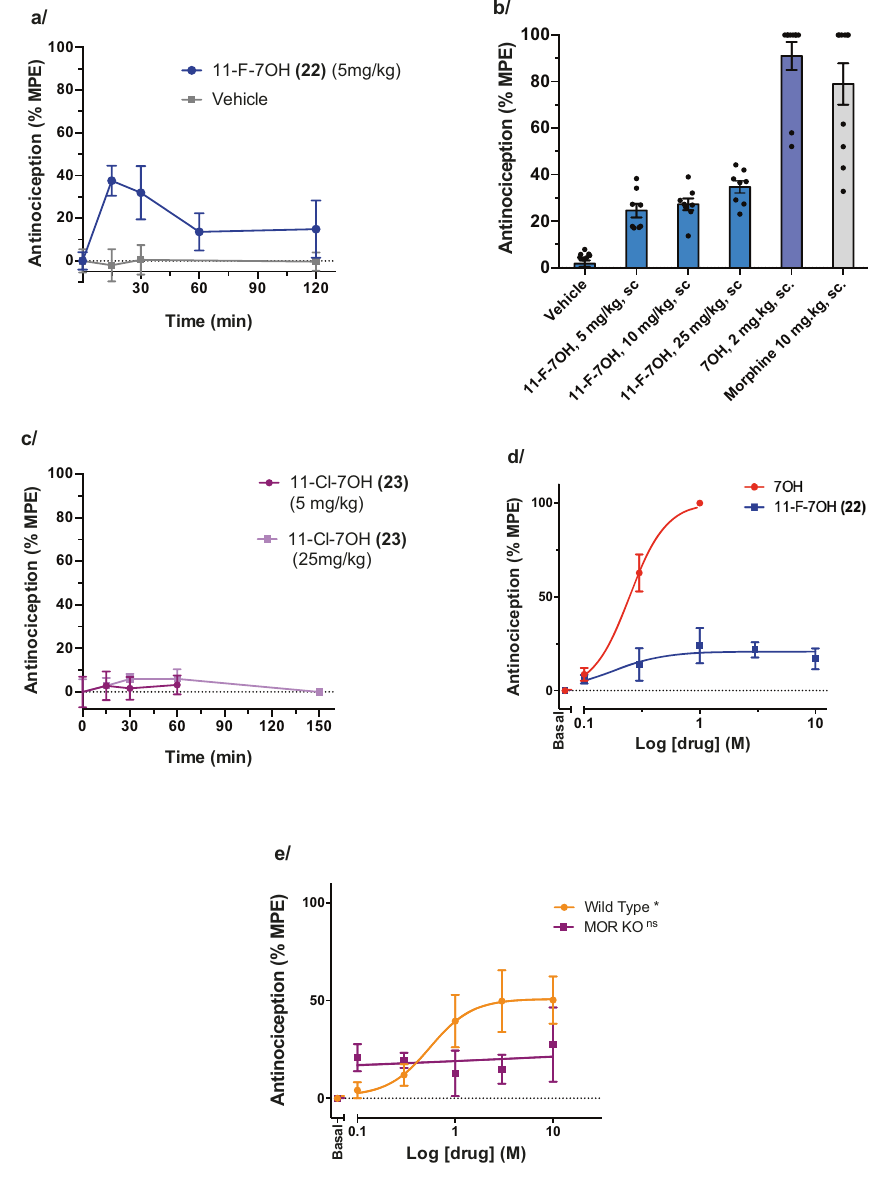
Fig. 9 Antinociceptive effects of 7OH analogs in tail- fl ick assay in mice. a Time course of the antinociceptive effect of 22 (5 mg/kg. s.c., n = 11 CD1 mice) and vehicle ( n = 6 CD1 mice) in the tail- fl ick assay. Each point represents mean ± SEM. % MPE, a percentage of the maximum possible effect as set in this assay (see Supplementary information). b Tail- fl ick dose – response for the high-dose range (5, 10, and 25 mg/kg, s.c.; n = 8 CD1 mice each group) of 22 , in direct comparison to controls 7OH and morphine. CD1 mice ( n = 10), at peak analgesic time point. (Vehicle ( − 5.4, 7.8, 4.0), 11-F-7OH 5 mg/kg (17.3,